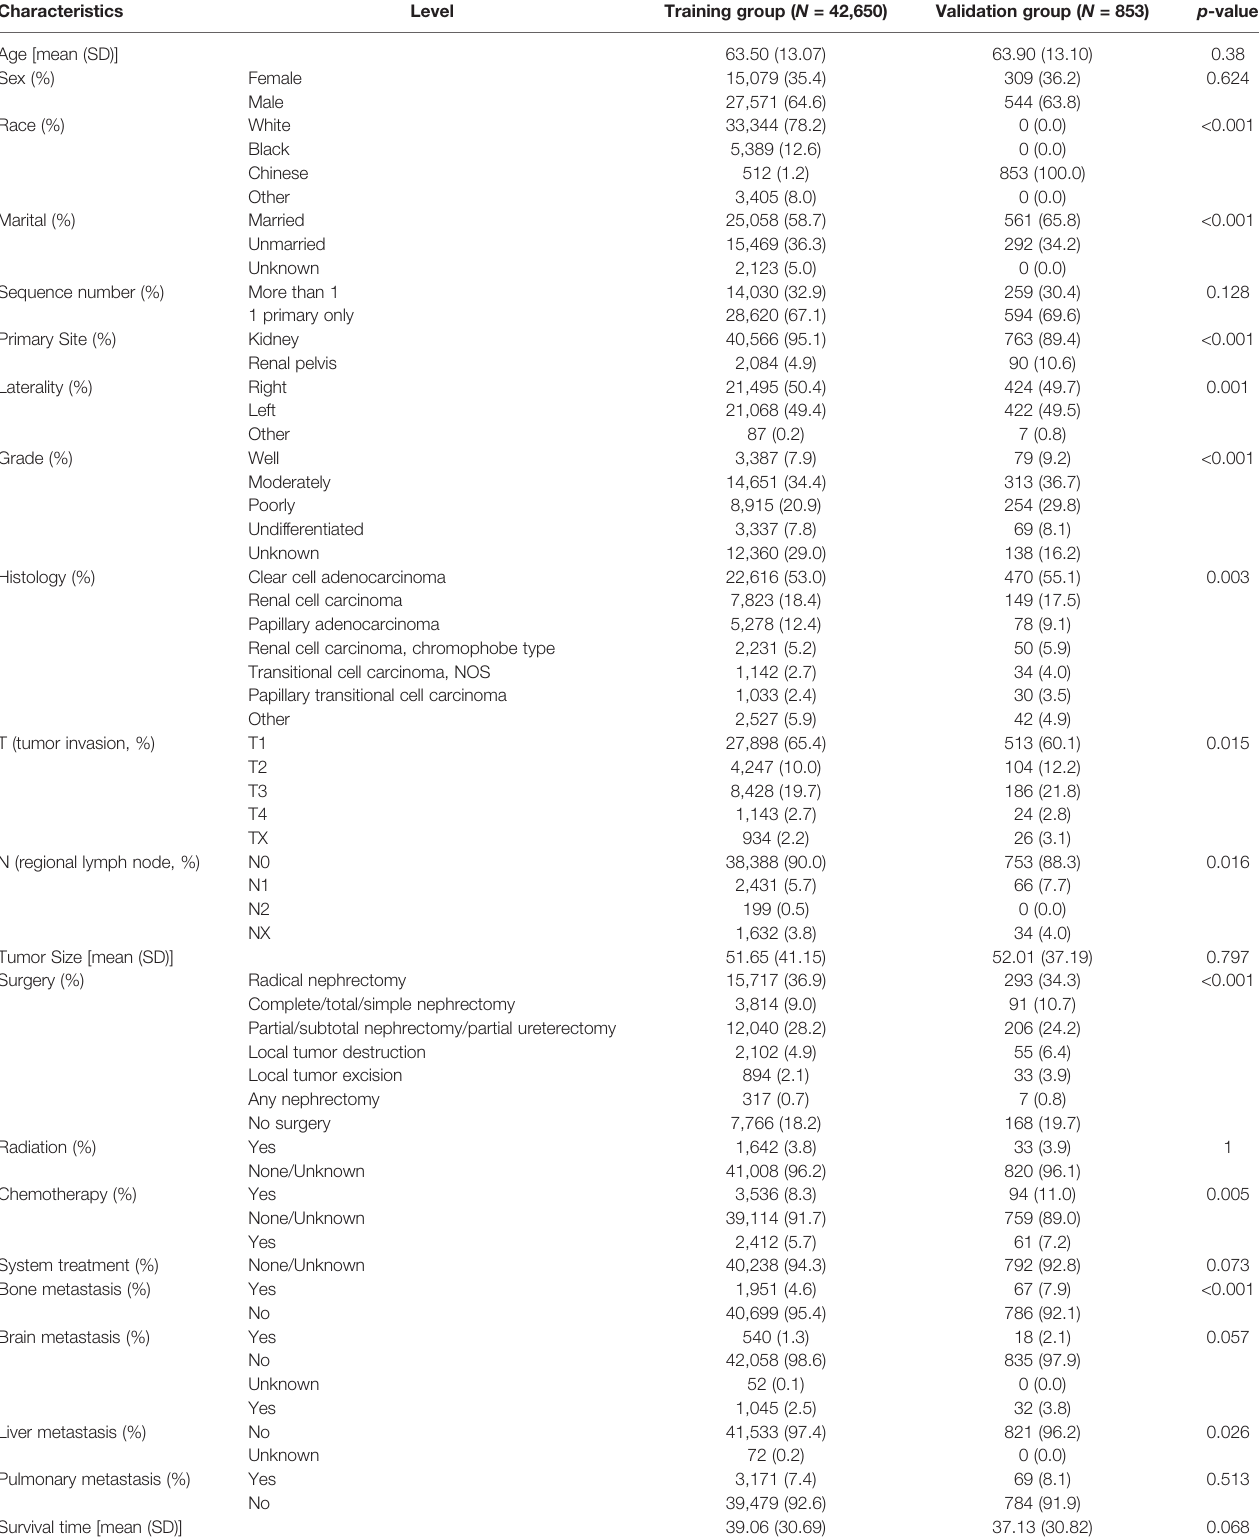
TABLE 1 | Comparison of patients in the training group and validation group.